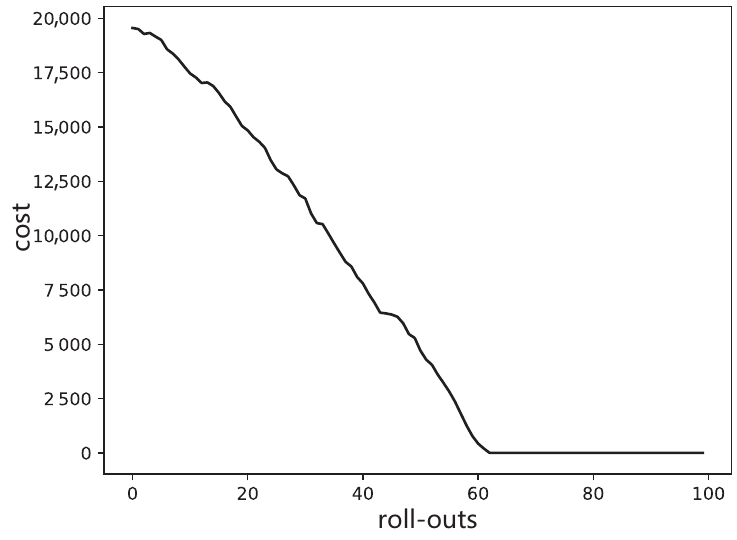
Figure 6. Via-point learning cost profiles with